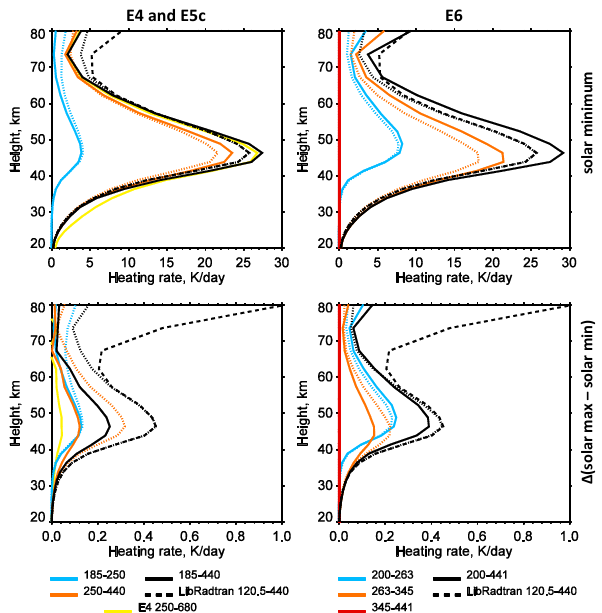
Figure 2. Shortwave heating rates in Kday − 1 for tropical stan- dard atmosphere and solar zenith angle equal to 10 ◦ calculated by E5c and E4 (left panels) and E6 (right panels). Top panels: abso- lute values during solar minimum. Bottom panels: differences be- tween minimum and maximum (max-min) of the 11-year solar cy- cle. Solid lines: ECHAM results. Dotted lines: libRadtran results for the same spectral intervals. Different spectral intervals are desig- nated by colours; yellow line – E4 250–680 band; black dashed line – libRadtran results for 120–440nm (i.e. including shortest wave- lengths > 120nm).